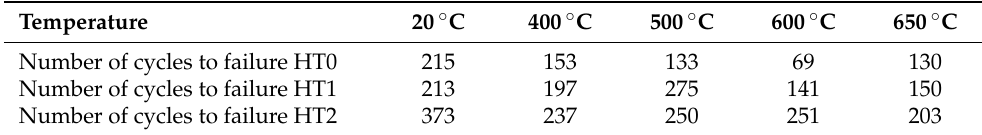
Table 3. Overview of the CLCF tests with the number of cycles to failure.